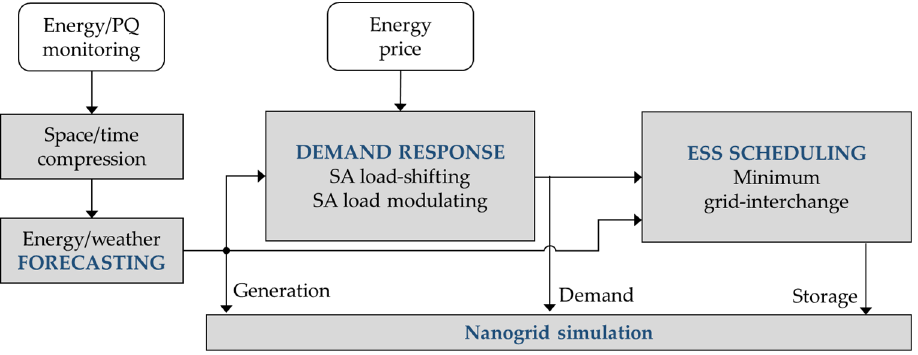
Figure 1. Scheme of the stages of the proposed energy management system for the nanogrid.